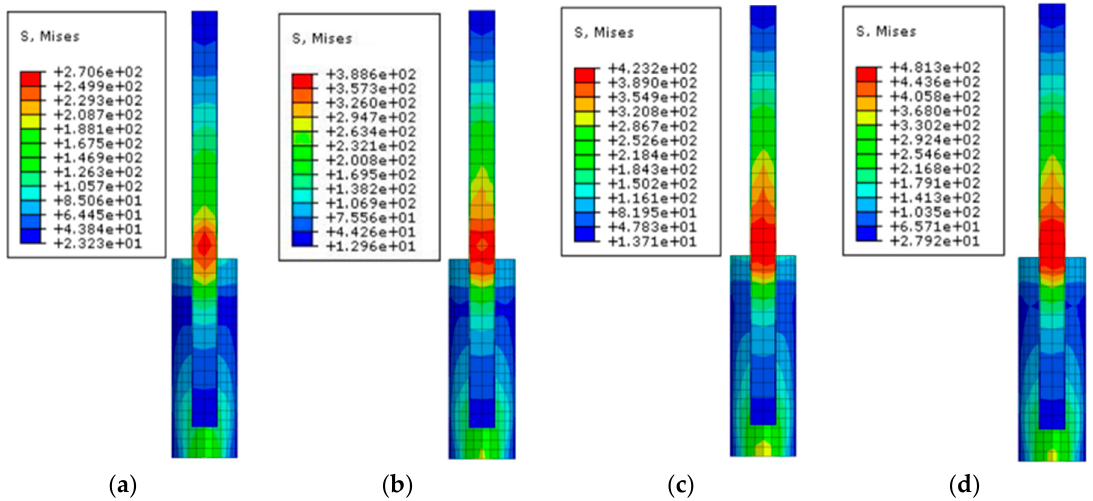
Figure 18. The stress cloud of the steel tube of TY specimen at failure: ( a ) TY-1; ( b ) TY-2; ( c ) TY-3; ( d ) TY-4.